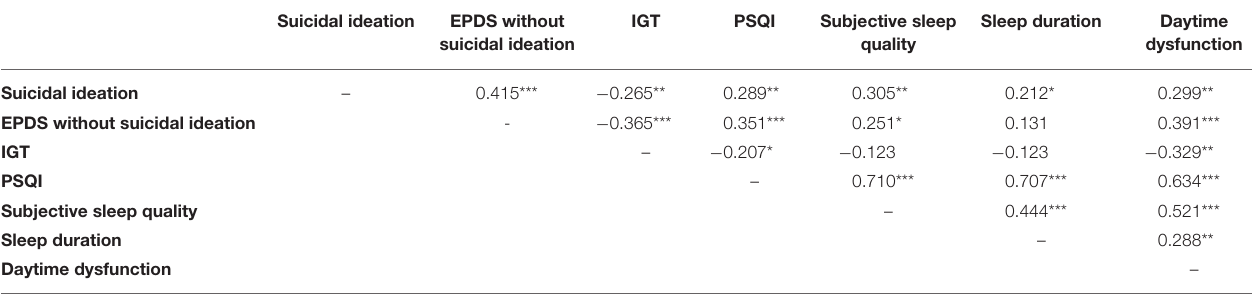
TABLE 4 | Spearman correlation matrix of suicidal ideation, PSQI and